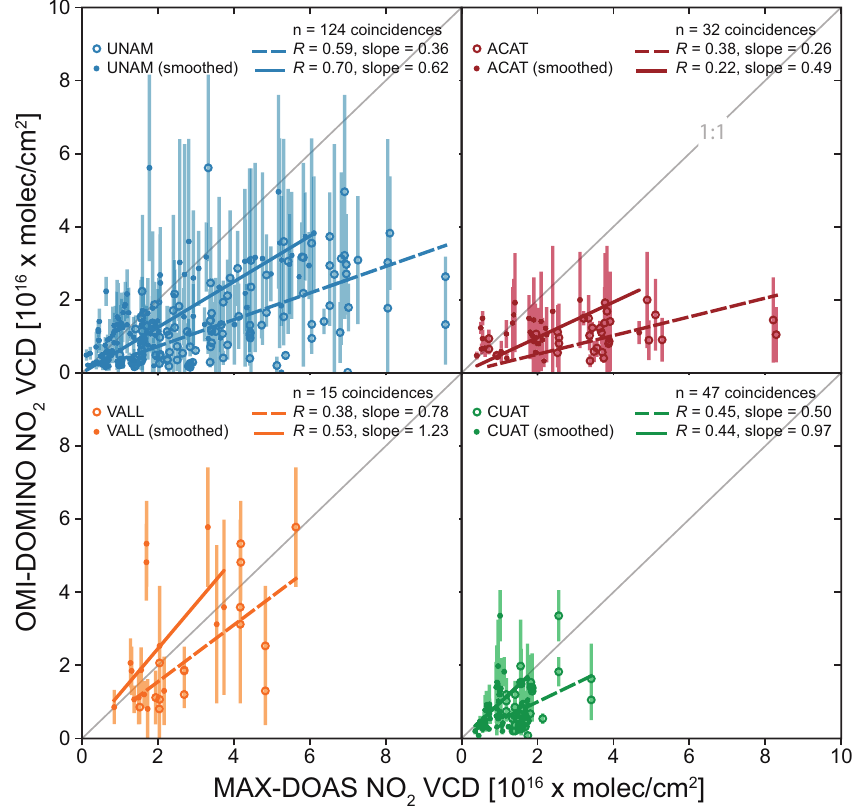
Figure 3. Correlation plots with coincident data pairs from OMI-DOMINO and each MAX-DOAS instrument in the MCMA taken between 2013 and 2018. Offsets forced to zero, with and without AK smoothing, are shown for UNAM (blue), Vallejo (orange), Acatlán (red), and Cuautitlán (green). In the right panel of Figure 4 are the AKs from MAX-DOAS and that from the OMI- DOMINO product interpolated to the MAX-DOAS layer scheme.The OMI’s AK